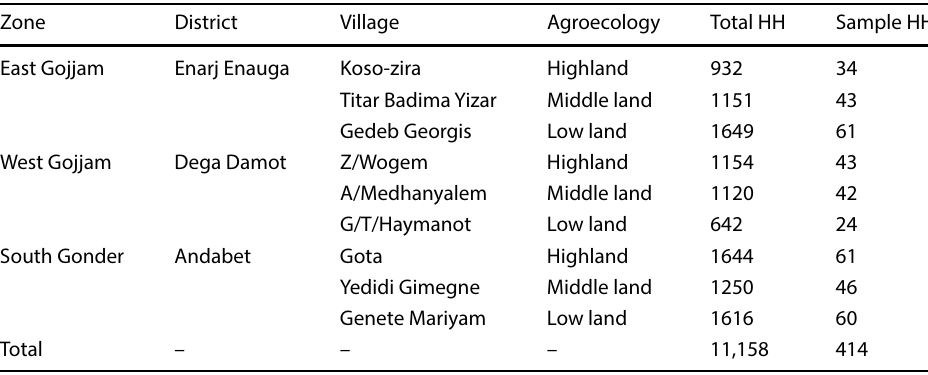
Table 1 Distribution of respondents by agro-ecology and administrations (Source: